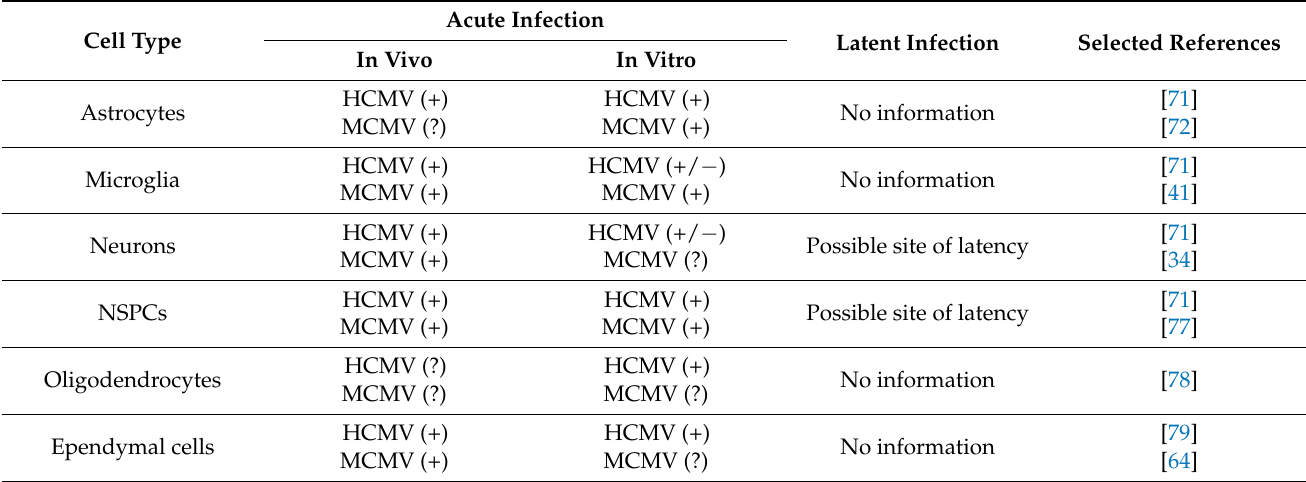
Table 1. HCMV and MCMV infection of brain-resident